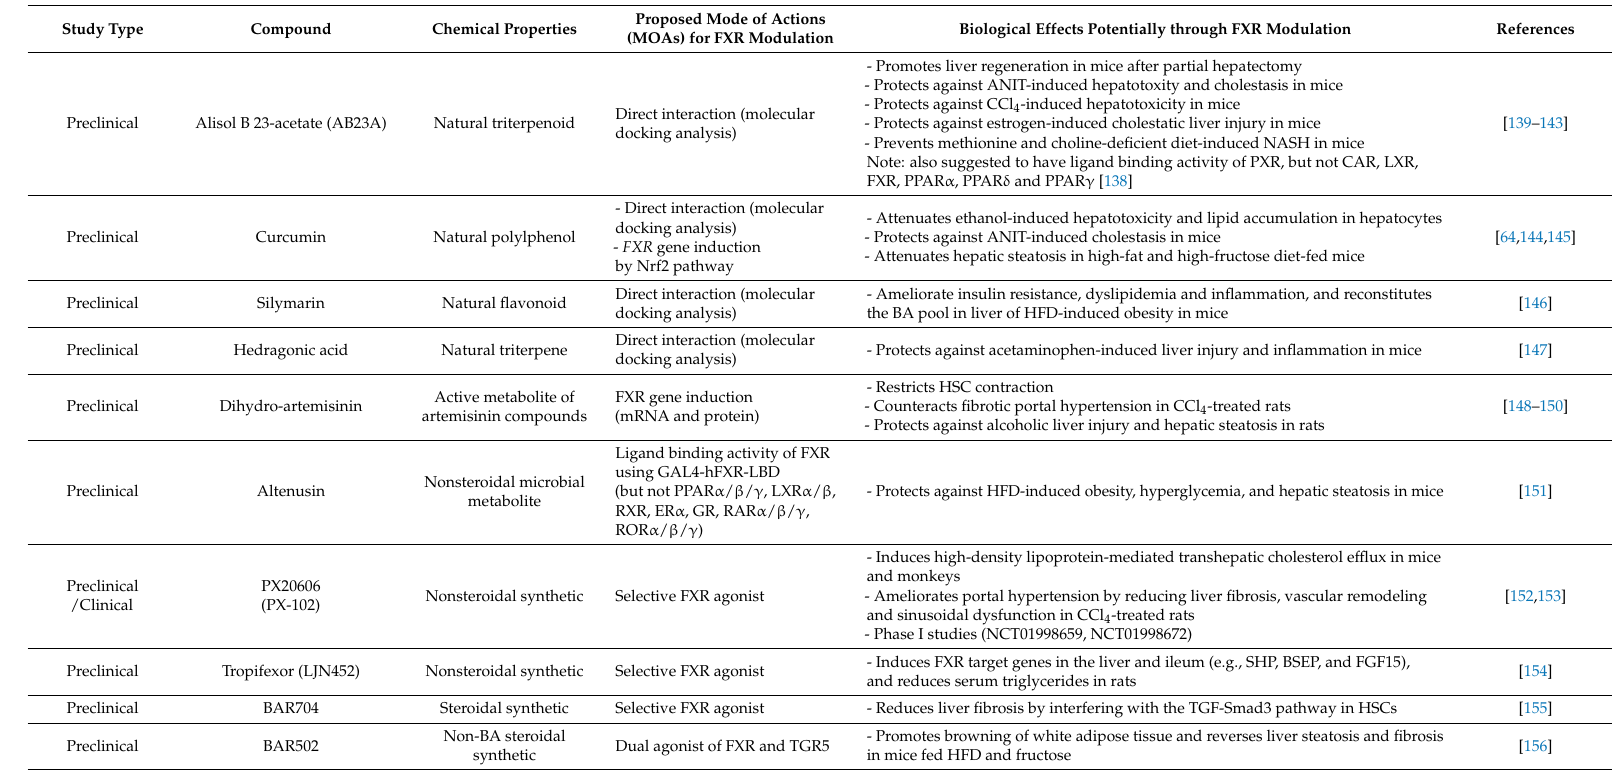
Table 1. Novel candidate compounds for farnesoid X receptor (FXR) agonism/activation. ANIT— α -naphthylisothiocyanate; BA—bile acid; BSEP—bile salt export pump; CAR—constitutive androstane receptor; ER—estrogen receptor; GR—glucocorticoid receptor; HFD—high-fat diet; HSC—hepatic stellate cells; LXR—liver X receptor; NASH—nonalcoholic steatohepatitis; PPAR—peroxisome proliferator-activated receptor; RAR—retinoic acid receptor; ROR—RAR-related orphan receptor; SHP—small heterodimer partner; TGF—transforming growth